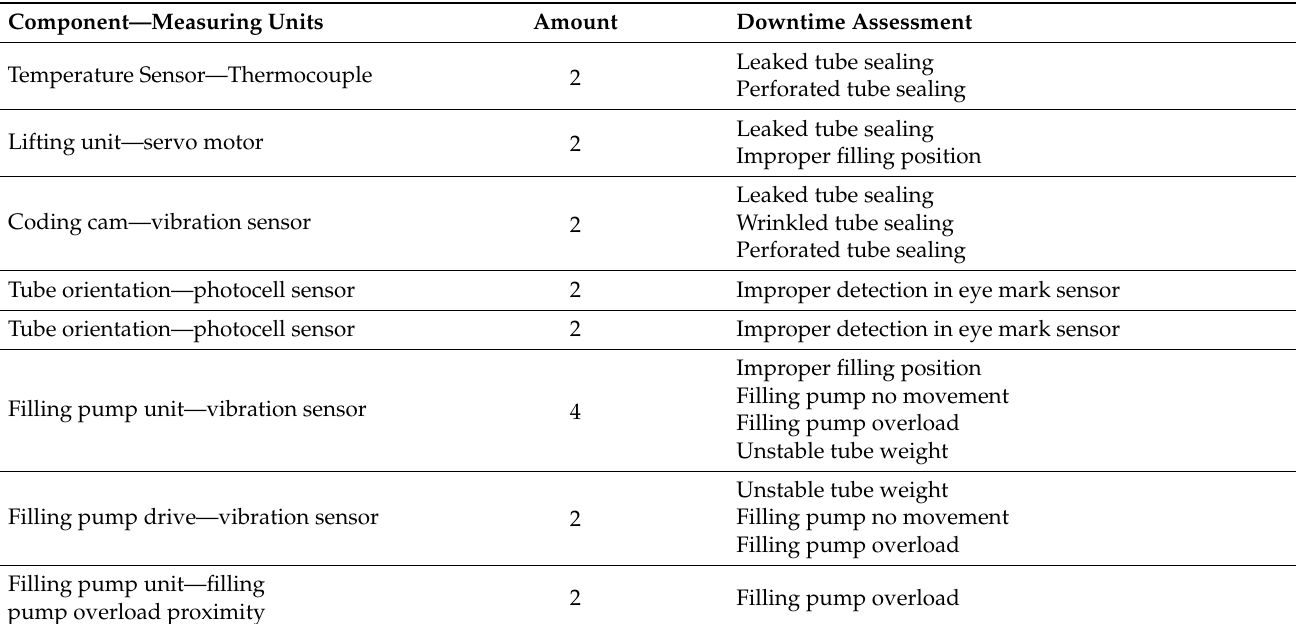
Table 3. Component classification table from filling machine NML 150